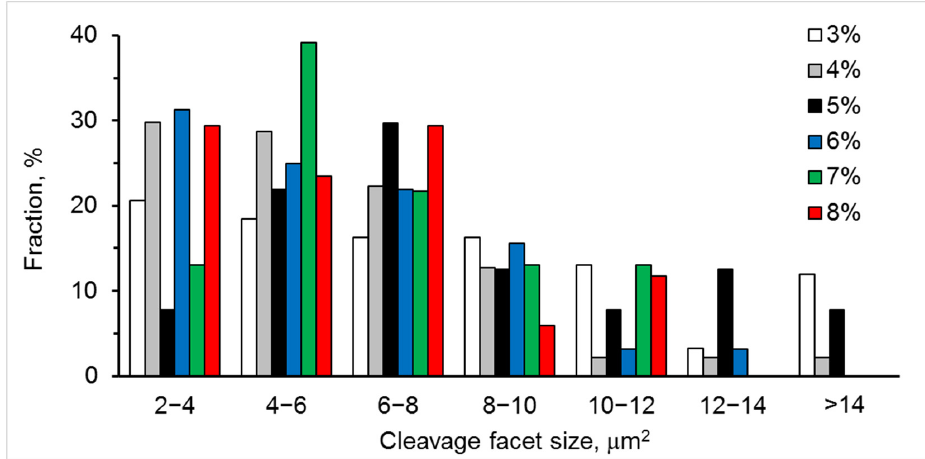
Figure 11. Size distributions of cleavage facets for six studied materials with 3–8% Y 2 O 3 . In terms of average sizes of fracture voids and cleavage facets, the following depend- ences were discovered with an increase in Y 2 O 3 content from 3 to 8%: - The average size of fracture voids decreased by 2 times (Table 1), the standard devi- ation of size decreased by 3.5 times, and the number density of voids increased by 3.8 times—all of these mean that the fracture became more homogeneous with an increase in the Y 2 O 3 content; - The average size of cleavage facets (associated with a transgranular fracture) de- creased by 30%, the number density of cleavage facets decreased by 5.4 times, and the transgranular fracture area decreased by 6.8 times—all of these indicated that the microstructure became finer, and cohesion between grains increased sufficiently to stimulate the fracture propagation along the boundaries of fine-grained agglomer- ates, except for occasional transgranular fracture through the larger grains with an increased Y content. The observed variations in fracture voids and cleavage facets are in line with the flex- ural strength dependence on yttria content (Figure 12). The minimum strength of 5YSZ ceramic corresponds to the relatively high fraction of coarse fracture voids (>0.9 μ m) and cleavage facets (>12 μ m 2 ). The 7YSZ ceramic, having the highest strength, exhibited a peak fraction of the smallest voids (<0.3 μ m) and small cleavage facets (4–6 μ m 2 ). Figure 12. Flexural strength of six studied materials with 3–8% Y 2 O 3 . The YSZ ceramics was shown to contain comparatively large areas of the m-ZrO 2 phase distributed more or less uniformly in the fine-grained t-ZrO 2 phase [33]. Therefore,